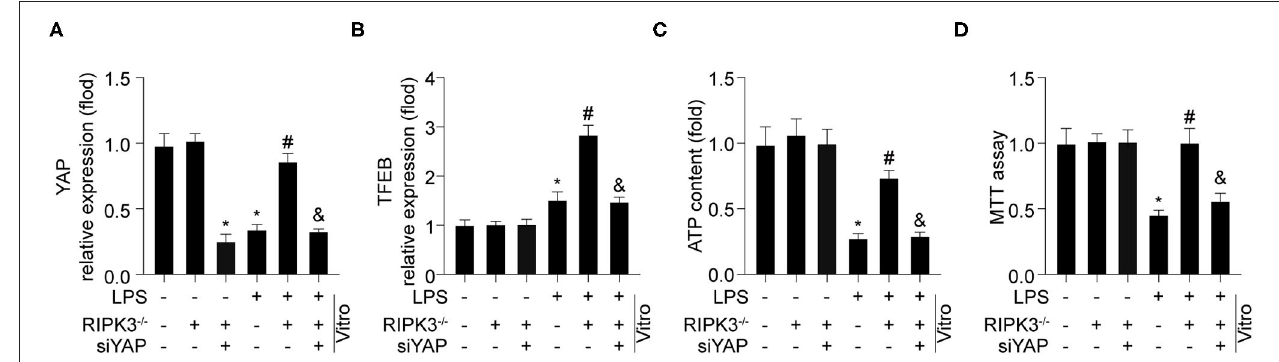
FIGURE 5 | RIPK3 controls TFEB mediated cardiac protection via YAP pathway ( n = 6/group). (A) Cardiomyocytes were isolated from WT and RIPK3 − / − mice and then treated with LPS (5 µ g/ml) to to induce sepsis-related cardiomyocyte damage. siRNA against YAP (si-YAP) was transfected into RIPK3 − / − cells to reduced TFEB expression under LPS challenge. YAP (A) and TFEB (B) expression was detected via western blot. (C) TP generation was measured by an ATP Bioluminescence Assay Kit. (D) MTT assay were used to measure cardiomyocytes viability. * p < 0.05 vs. WT group. # p < 0.05 vs. WT + LPS group. & p < 0.05 vs. LPS + RIPK3 − / −